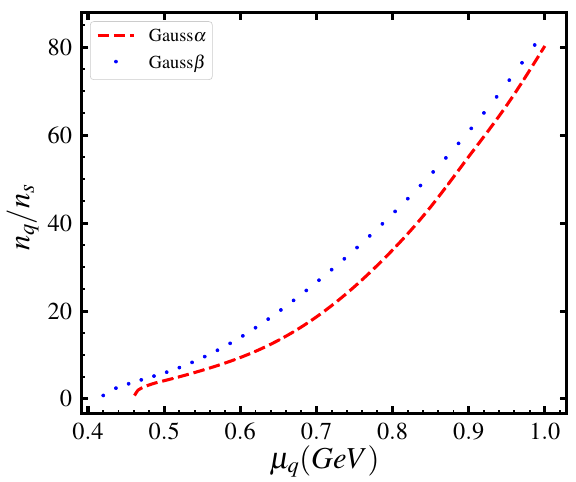
Fig. 6 Calculated number density (in unit of the saturation nuclear matter density n S ) of the s quark as a function of the quark chemi- cal potential. The red dashed line corresponds to the result using the Gaussian-type gluon model with the α -type modification, and the blue dotted line stands for the result with the β -type